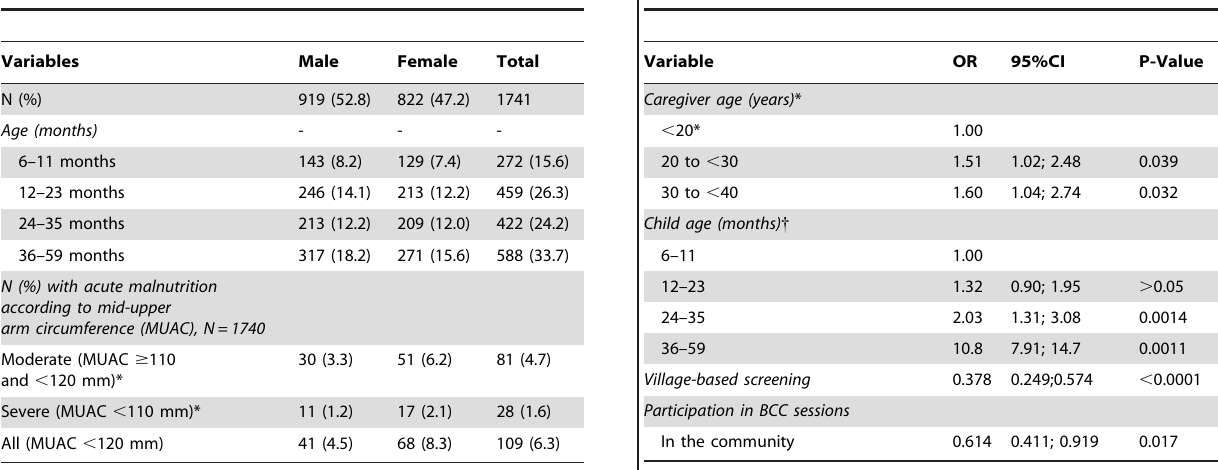
Table 2. Description of the study children 6–59 months.